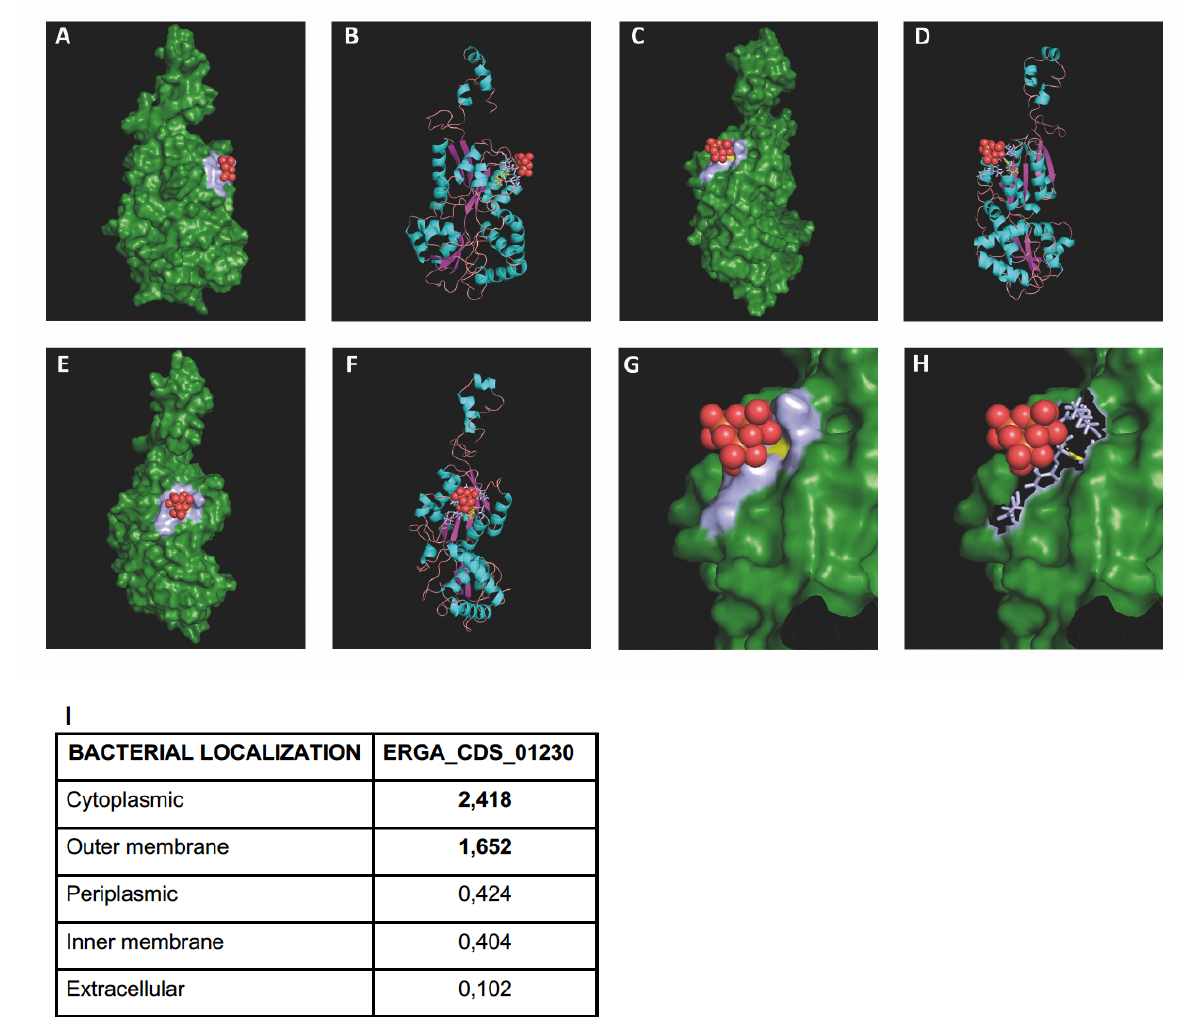
Figure 2. Structural characterization of Ape protein. (A-H) I-TASSER-MTD derived 3D-prediction of the ERGA_CDS_01230 gene product (Ape protein in green) interacting with oxo-iron molecule (red). Front (A- B), back (C-D) and side (E-F) views of Ape showing a succession of α-helixes (turquoise) linked by loops (pink) distributed around β-sheets (purple), organized as a three-dimensional “c-clamp” structure. The enlarged panels (G-H) of the binding site allow the visualization of the residues involved in polar (yellow) and non polar (light blue) interactions. The oxo-iron molecule (CIN1) constituted by 3 atoms of iron (orange) and 12 atoms of oxygen (red) interacts with Ape protein (green) via polar interaction (hydrogen bond with T99 in yellow) and non-polar interactions (hydrophobic interactions in light blue involving L120 and Q122) bonds. (I) Reliability score prediction by CELLO 2.5 software of the subcellular localization of the native E. ruminantium Ape protein. Ape presents a typical subcellular localization of an active transporter, with a dominant cytoplasmic localization and is also present at the outer membrane. rApe protein shows O-glycosylated post-traductional modifications Western blot analysis showed that rApe was detected with an anti-O-GlcNAc antibody at the expected size of 66kDa (Figure 3). This size confirmed the data obtained by mass spectrometry and is 30% larger than the one estimated by the amino acid sequence encoded by ape gene (41 kDa for 365 amino acids). The identity of rApe protein sequence blasted with the possible major ferric iron binding protein precursor (Q5FFA9). Altogether these results demonstrate the O-glycosylation of